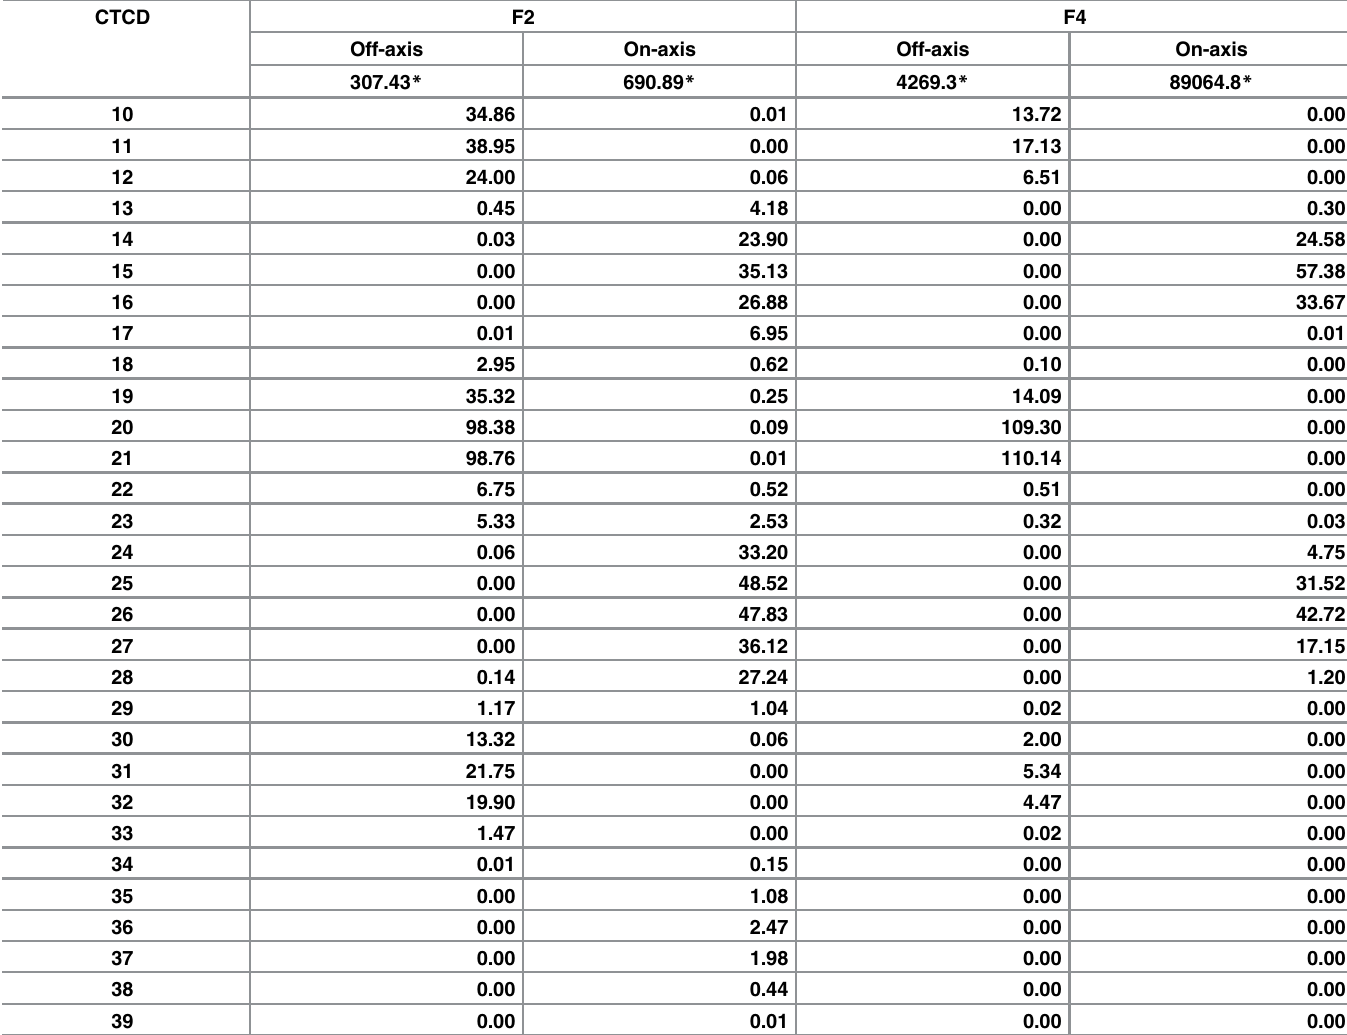
Table 1. Computed scaled feasibility measures using 10.5 bps/turn